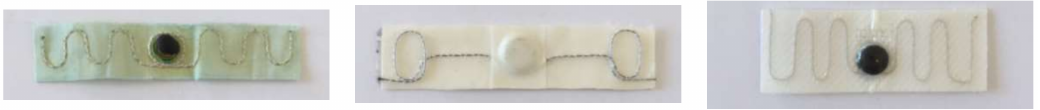
Figure 6. The geometries of UHF antennas for some UHF RFID passive